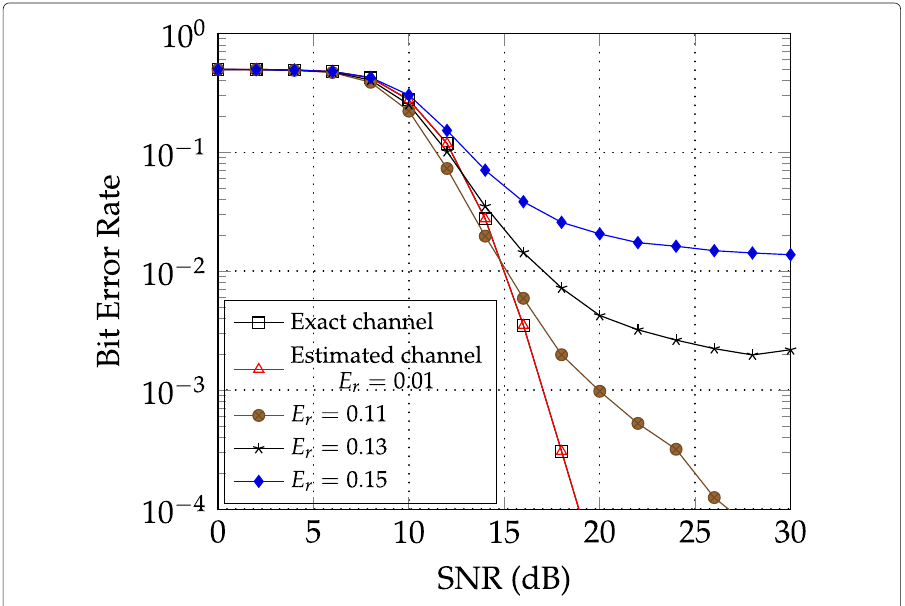
Fig. 11 LU-PMD: BER performance with imperfect channel estimation